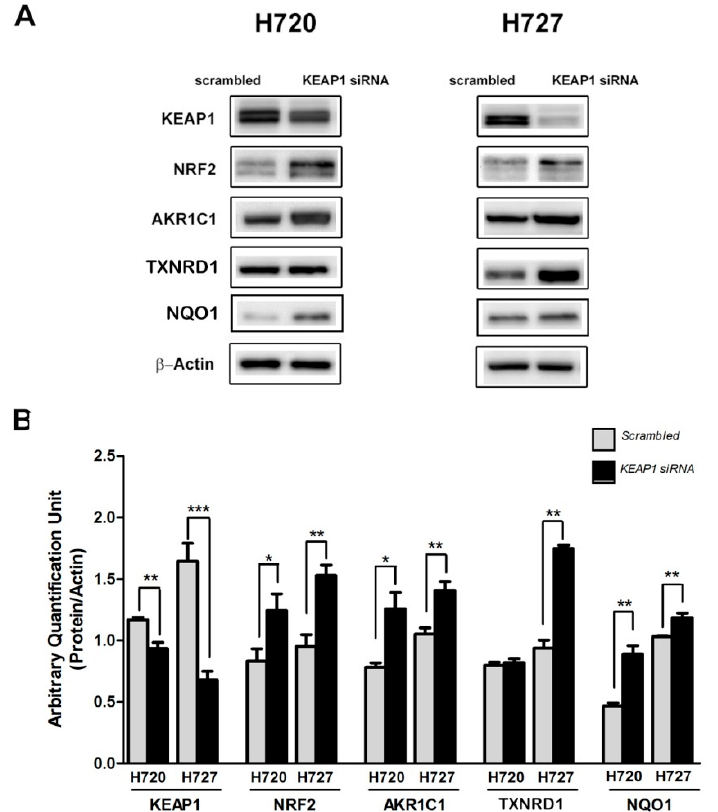
Figure 1. ( A ) Representative Western Blots analysis showing expression levels of KEAP1, NRF2, AKR1C1 and TXNRD1 in H720 and 727 cell lines after KEAP1 inhibition by specific KEAP1